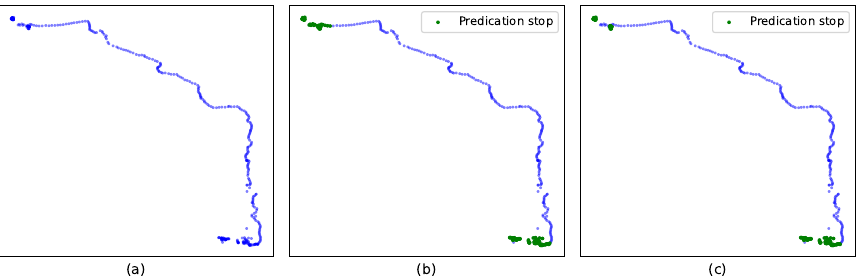
Figure 7. The result of stopping point extraction: ( a ) original trajectory, ( b ) one-step DPCC-TE, ( c ) two-step DPCC-TE.